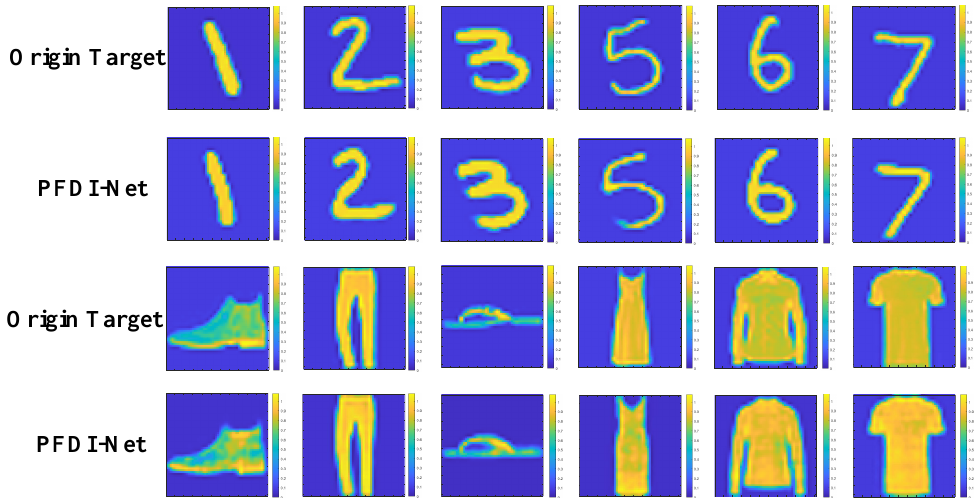
Figure 4. Reconstruction results from PFDI-Net with different scene target.